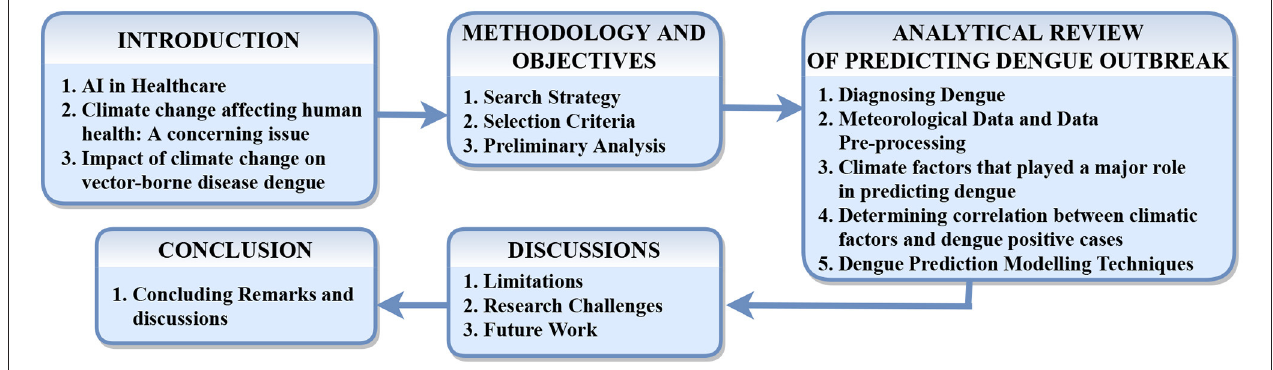
FIGURE 4 | Roadmap of the conducted